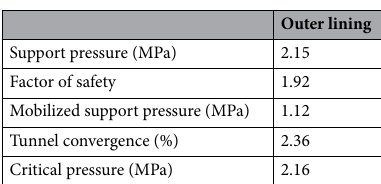
Table 8. Summary of the analysis